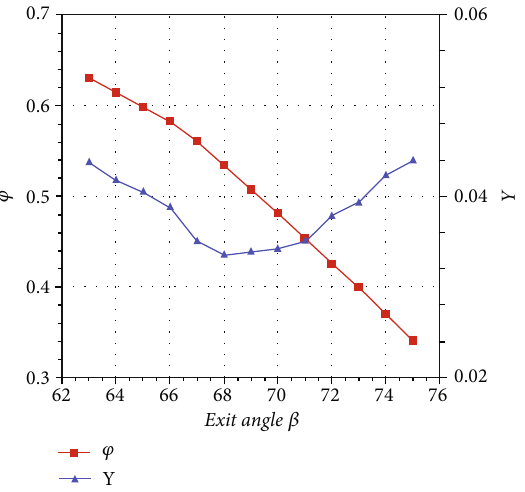
Figure 12: Flow coe ffi cient and total pressure loss coe ffi cient for di ff erent exit